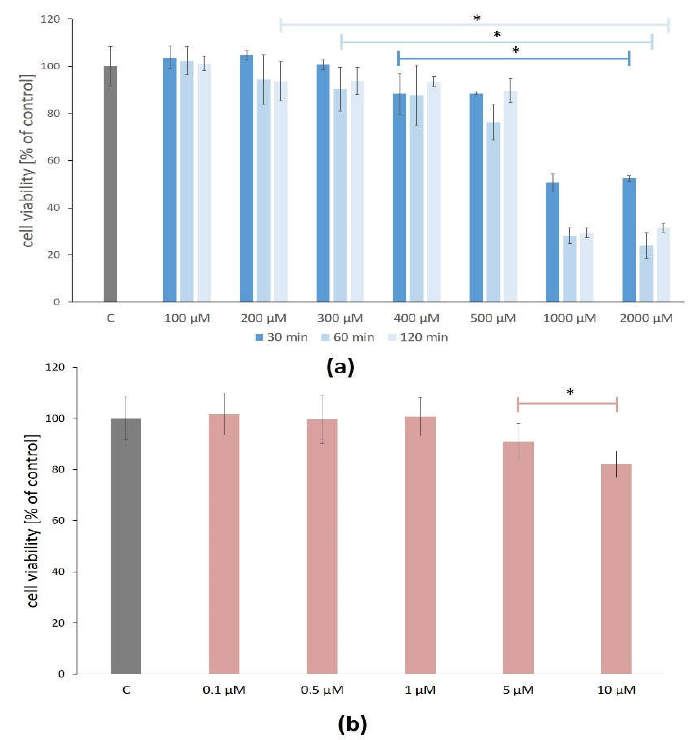
Figure 1. Cell viability of the ARPE-19 cells that were treated with ( a ) H 2 O 2 for 30, 60, and 120 min., as well as ( b ) treated with lutein for 24 h. Each bar represents the mean ± standard deviation (SD), Dunnett’s test, * p < 0.05 versus control (C). Sample size: five wells and three technical replicates for each concetration of H 2 0 2 and eight wells and three technical replicates for each concetration of lutein.